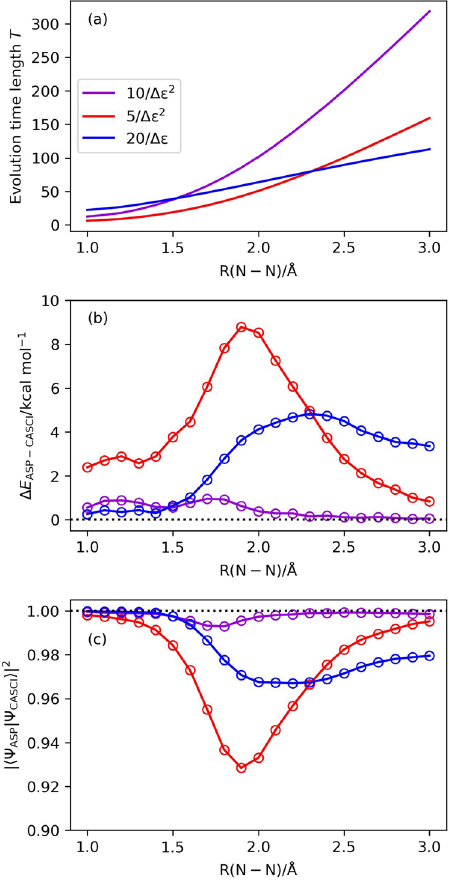
Fig. 5 Results of the numerical simulation of ASP with different evolution time length determination strategies in N 2 . Sinusoidal function is used for the scheduling function. a Evolution time length being tested. b The energy deviations from the CASCI values. c The square overlaps with the CASCI wave